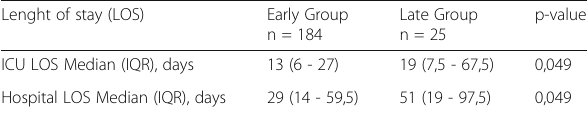
Table 2 (abstract 0391). Lenght of stay according to early antibiotic